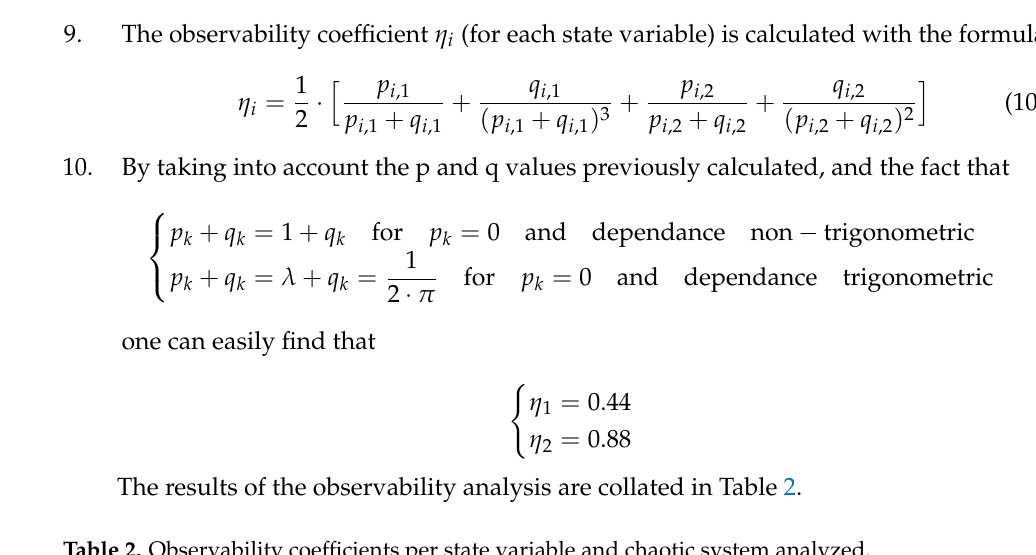
Table 2. Observability coefficients per state variable and chaotic system analyzed. Chaotic